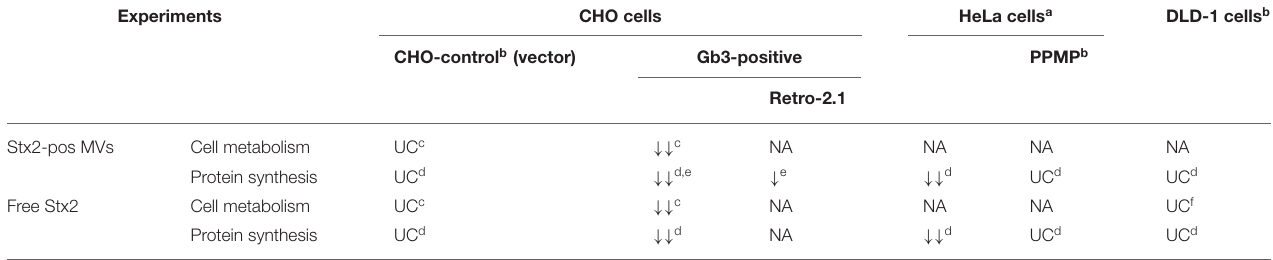
TABLE 1 | Cell metabolism and protein synthesis in cells exposed to Stx2-positive microvesicles and free toxin. Experiments CHO cells HeLa cells a DLD-1 cells b CHO-control b (vector) Gb3-positive PPMP b Retro-2.1 Stx2-pos MVs Cell metabolism UC c ↓↓ c NA NA NA NA Protein synthesis UC d ↓↓ d,e ↓ e ↓↓ d Free Stx2 Cell metabolism UC c ↓↓ c NA Protein synthesis UC d ↓↓ d NA UC d a Gb3-positive cells; b Gb3-negative cells; c Values are presented in Figure 1 ; d Values are presented in Figure 2 ; e Values are presented in Figure 3 ; f Values are presented in Figure 5 ; ↓ , Lowered cell metabolism/viability or protein synthesis; CHO, Chinese hamster ovary; DLD-1, intestinal epithelial cell line; Gb3, Globotriaosylceramide;